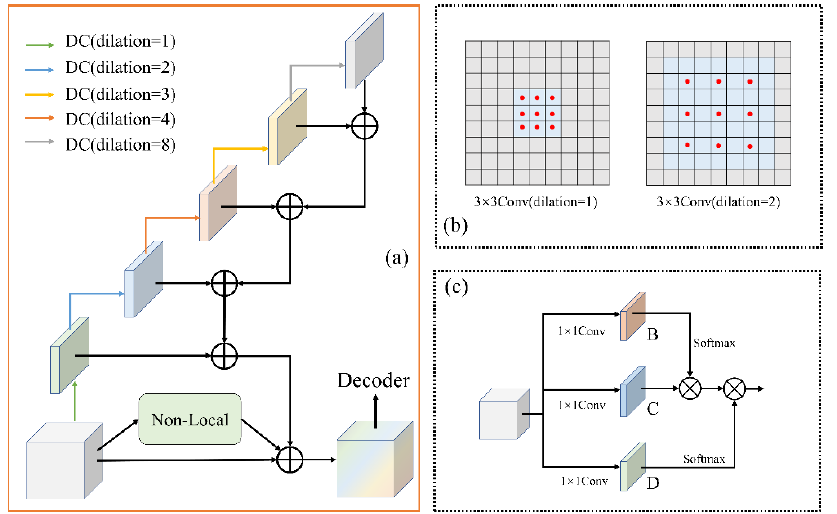
Figure 3. Overview of the GFIA module. ( a ) The structure of the GFIA module, ( b ) the comparison of standard convolution and dilated convolution, ( c ) the structure of the nonlocal units.